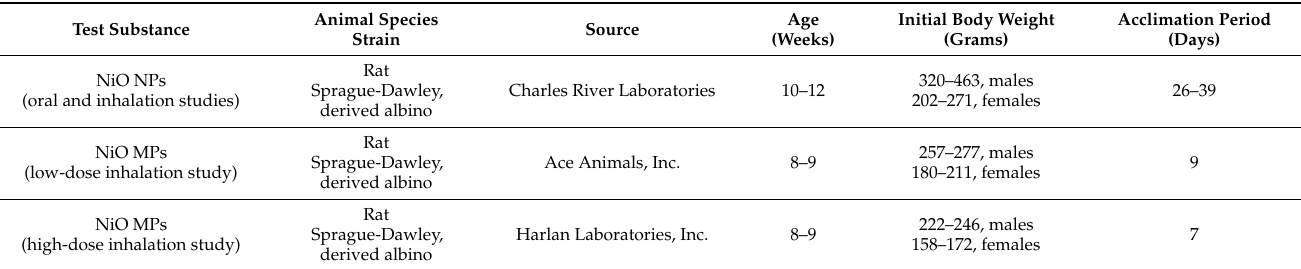
Table 2. Details about the animals used in the acute